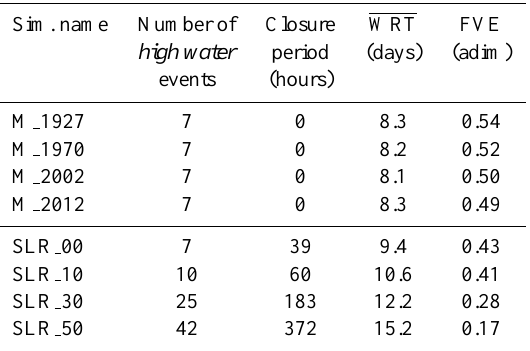
Table 4. Model results of monthly simulations in terms of basin- wide average water renewal time (WRT) and daily fraction of water lagoon volume exchanged with the open sea (FVE). Table reports also the number of high water events and the overall closure time of